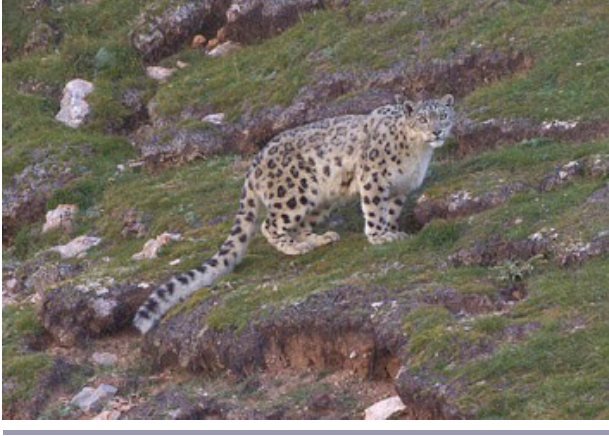
Bridge Route 3: Connect the local community